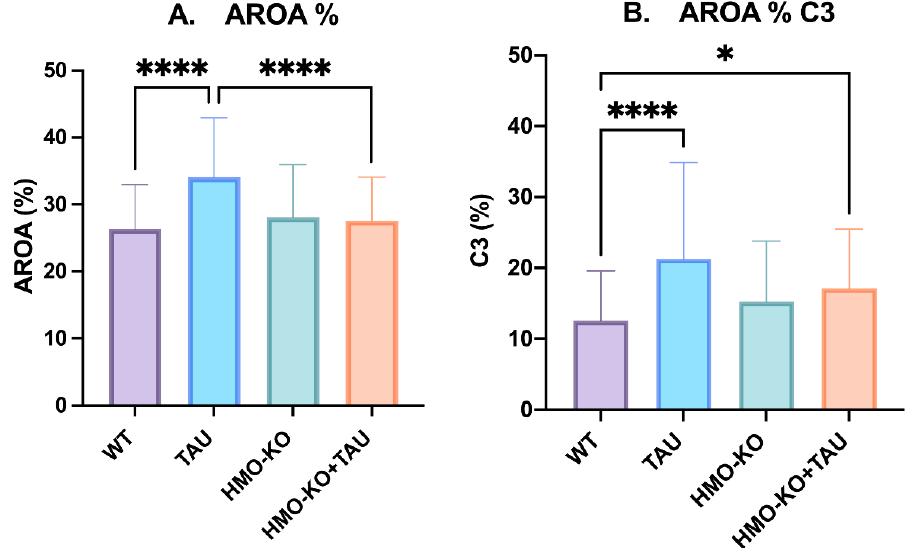
Figure 13. ( A ) Area of retina occupied by GFAP (AROA) in the different study groups. ( B ) Area of retina occupied by C3 (AROC3) in the different study groups. Data are expressed as mean values (±SD). One-way ANOVA; * p < 0.05, **** p < 0.0001. Number of retinas used in the experiment: WT n = 6, HMO-KO n = 6, TAU n = 6, and HMO-KO+TAU n = 6.